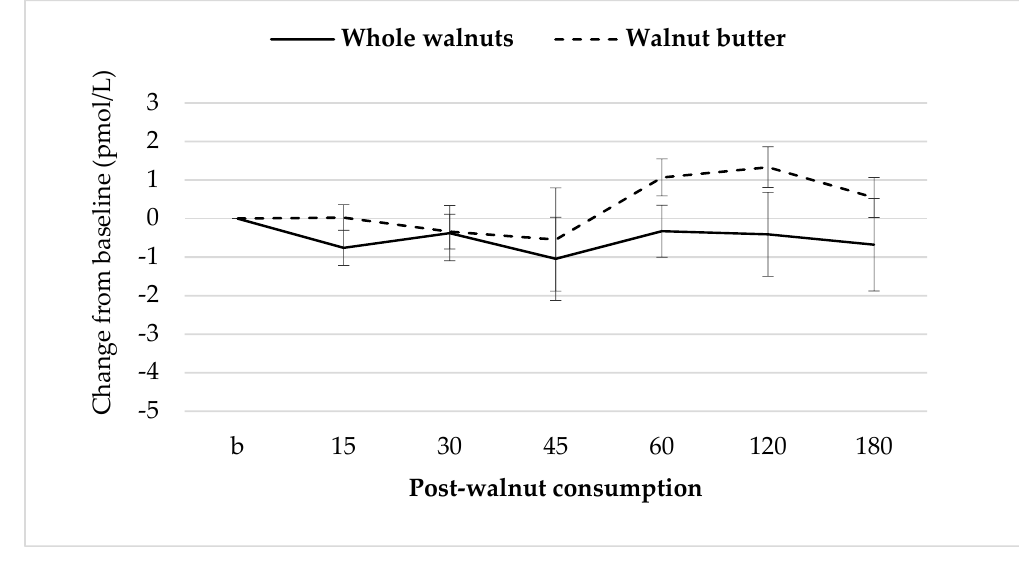
Figure 7. Mean ± S.E.M changes in GLP-1 concentrations after walnut consumption.